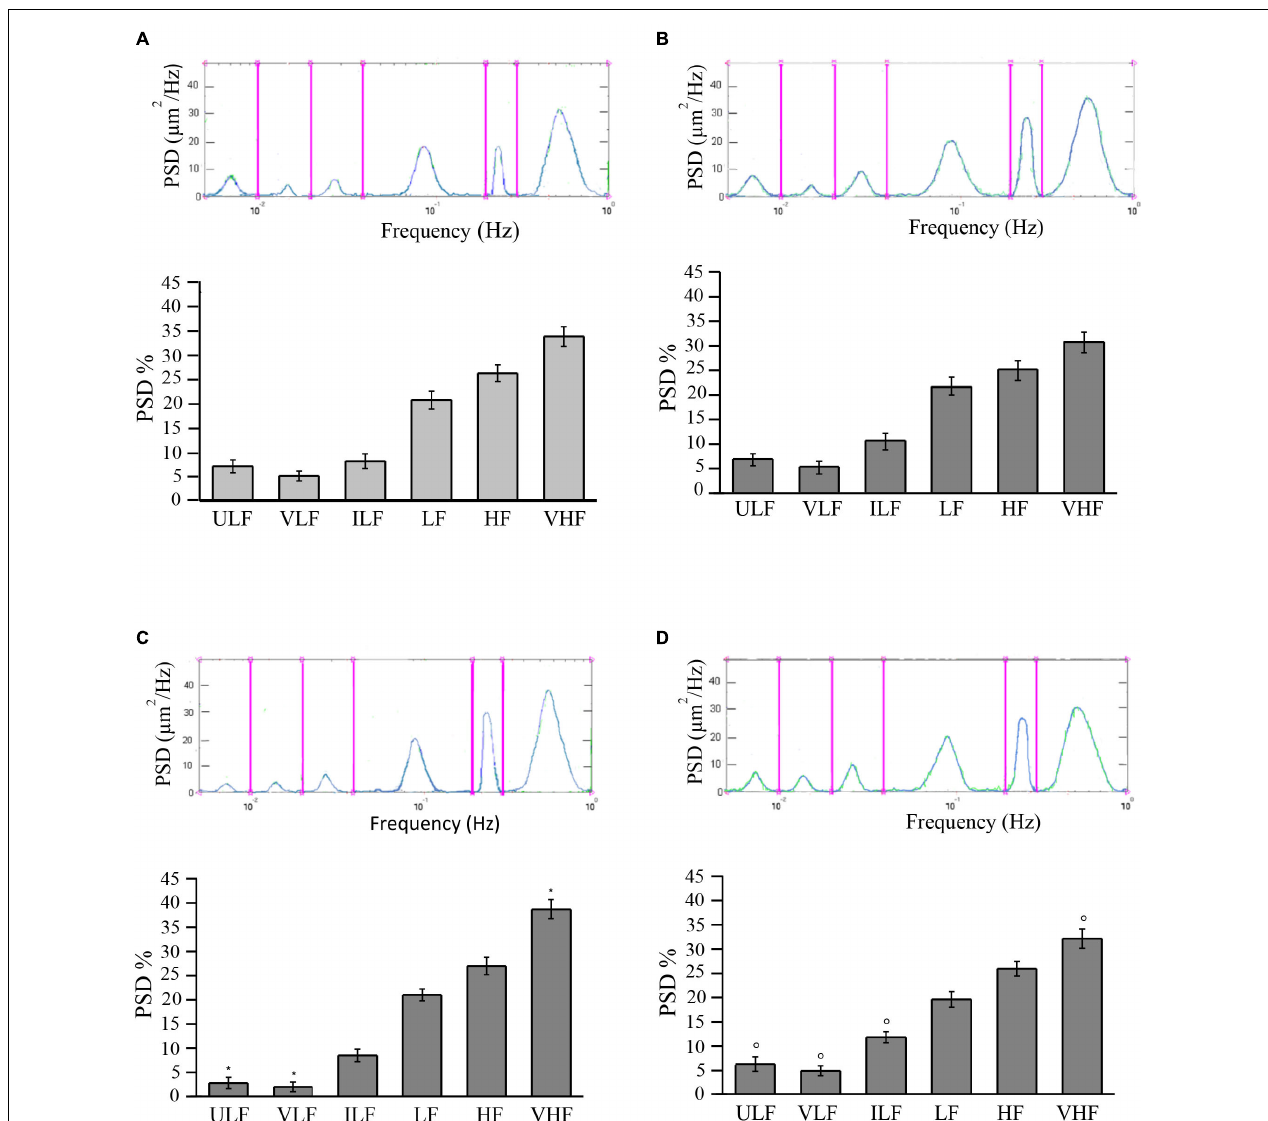
FIGURE 3 | Rhythmic diameter changes ( upper ) of order 3 arterioles and the six corresponding frequency components ( bottom ) expressed as percent normalized power spectral density (PSD, in square micrometers per hertz) in young spontaneously hypertensive rats (SHRs) (A) and in young normotensive age-matched rats (B) . Adult SHRs showed a significant decrease of the frequency components related to endothelial activity (ULF and VLF) compared with those detected in young SHRs. In (C,D) are the rhythmic diameter changes ( upper ) of order 3 arterioles and the six corresponding frequency components ( bottom ) expressed as percent normalized PSD (in square micrometers per hertz) in adult SHRs and in adult normotensive age-matched rats, respectively. Young and adult normotensive age-matched rats showed no significant change of all six frequency components when compared with each other, while there was a significant difference in ULF, VLF, ILF, and VHF when compared with adult SHRs. ULF , ultra-low frequency; VLF , very low frequency; ILF , intermediate low frequency; LF , low frequency; HF , high frequency; VHF , very high frequency. * p < 0.01, significantly different from the corresponding values observed in young SHRs; ◦ p < 0.01, significantly different from the corresponding values observed in adult